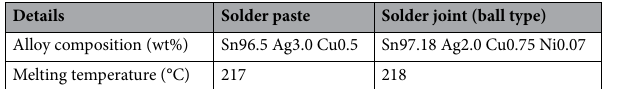
Table 2. Solder paste and BGA component solder ball material